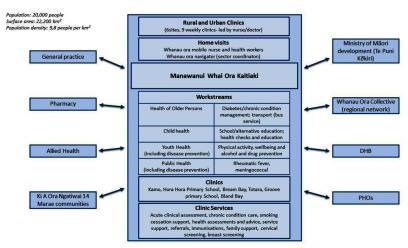
Ki A Ora Ngatiwai.